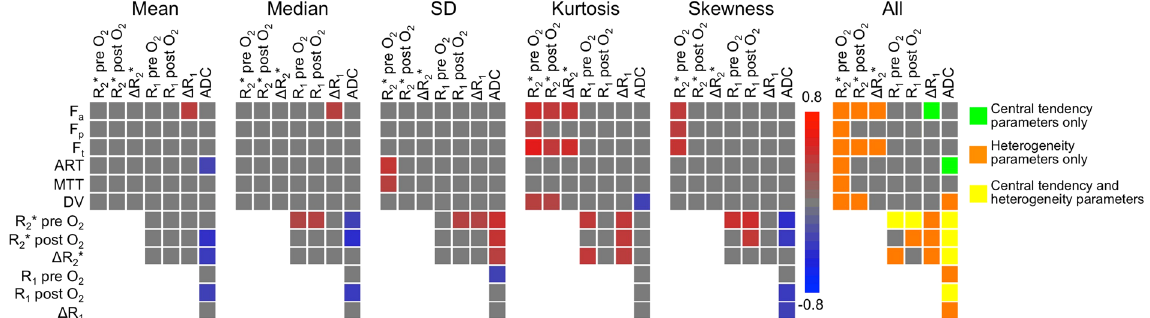
Figure 4. Heatmaps of correlations between mean, median, SD, kurtosis and skewness of MRI parameters in 39 HCC lesions (in 32 patients). Significant correlations ( P < 0.05) are coloured according to the scale bar. The correlation between R 1 pre and post O 2 and DCE-MRI parameters was not assessed, because the baseline R 1 measurements were used as input for the DCE-MRI modelling. A combined heatmap of all significant correlations between MRI features is shown on the right, illustrating additional information provided by heterogeneity parameters (SD, kurtosis and skewness). Significant correlations between DCE-MRI and BOLD were for example only seen for heterogeneity parameters and not for central tendency parameters (mean and median). ADC = apparent diffusion coefficient, ART = arterial fraction, DV = distribution volume, F a = arterial flow, F p = portal flow, F t = total flow, MTT = mean transit time, R 1 = longitudinal relaxation rate, R